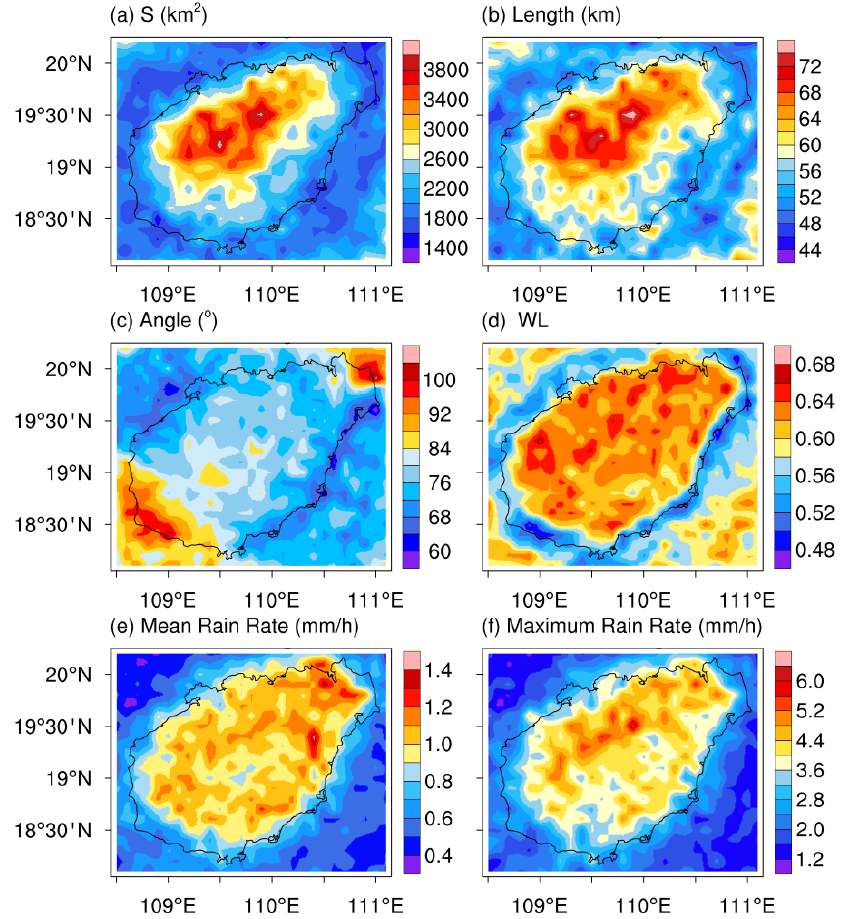
Figure 5. Spatial distribution of parameters of the rain clusters: ( a ) S , ( b ) length, ( c ) rotation angle, ( d ) WL , ( e ) mean rain rate and ( f ) maximum rain rate.